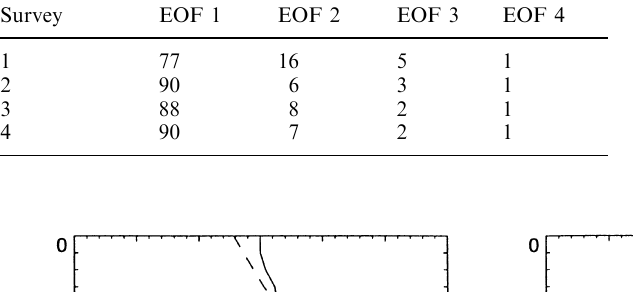
Table 2. Percentage of variance in each of the first four EOFs Survey